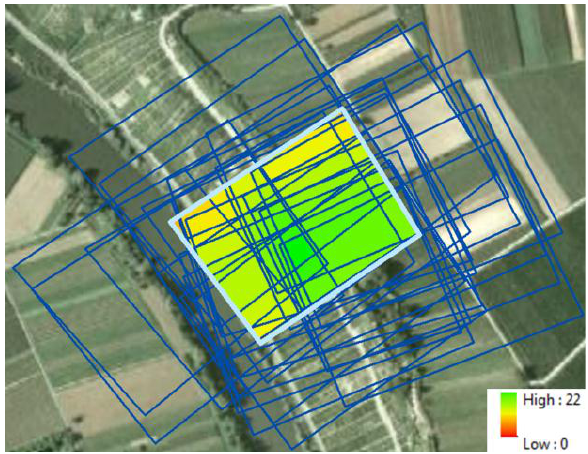
Figure 8: Amount of overlap for single image.